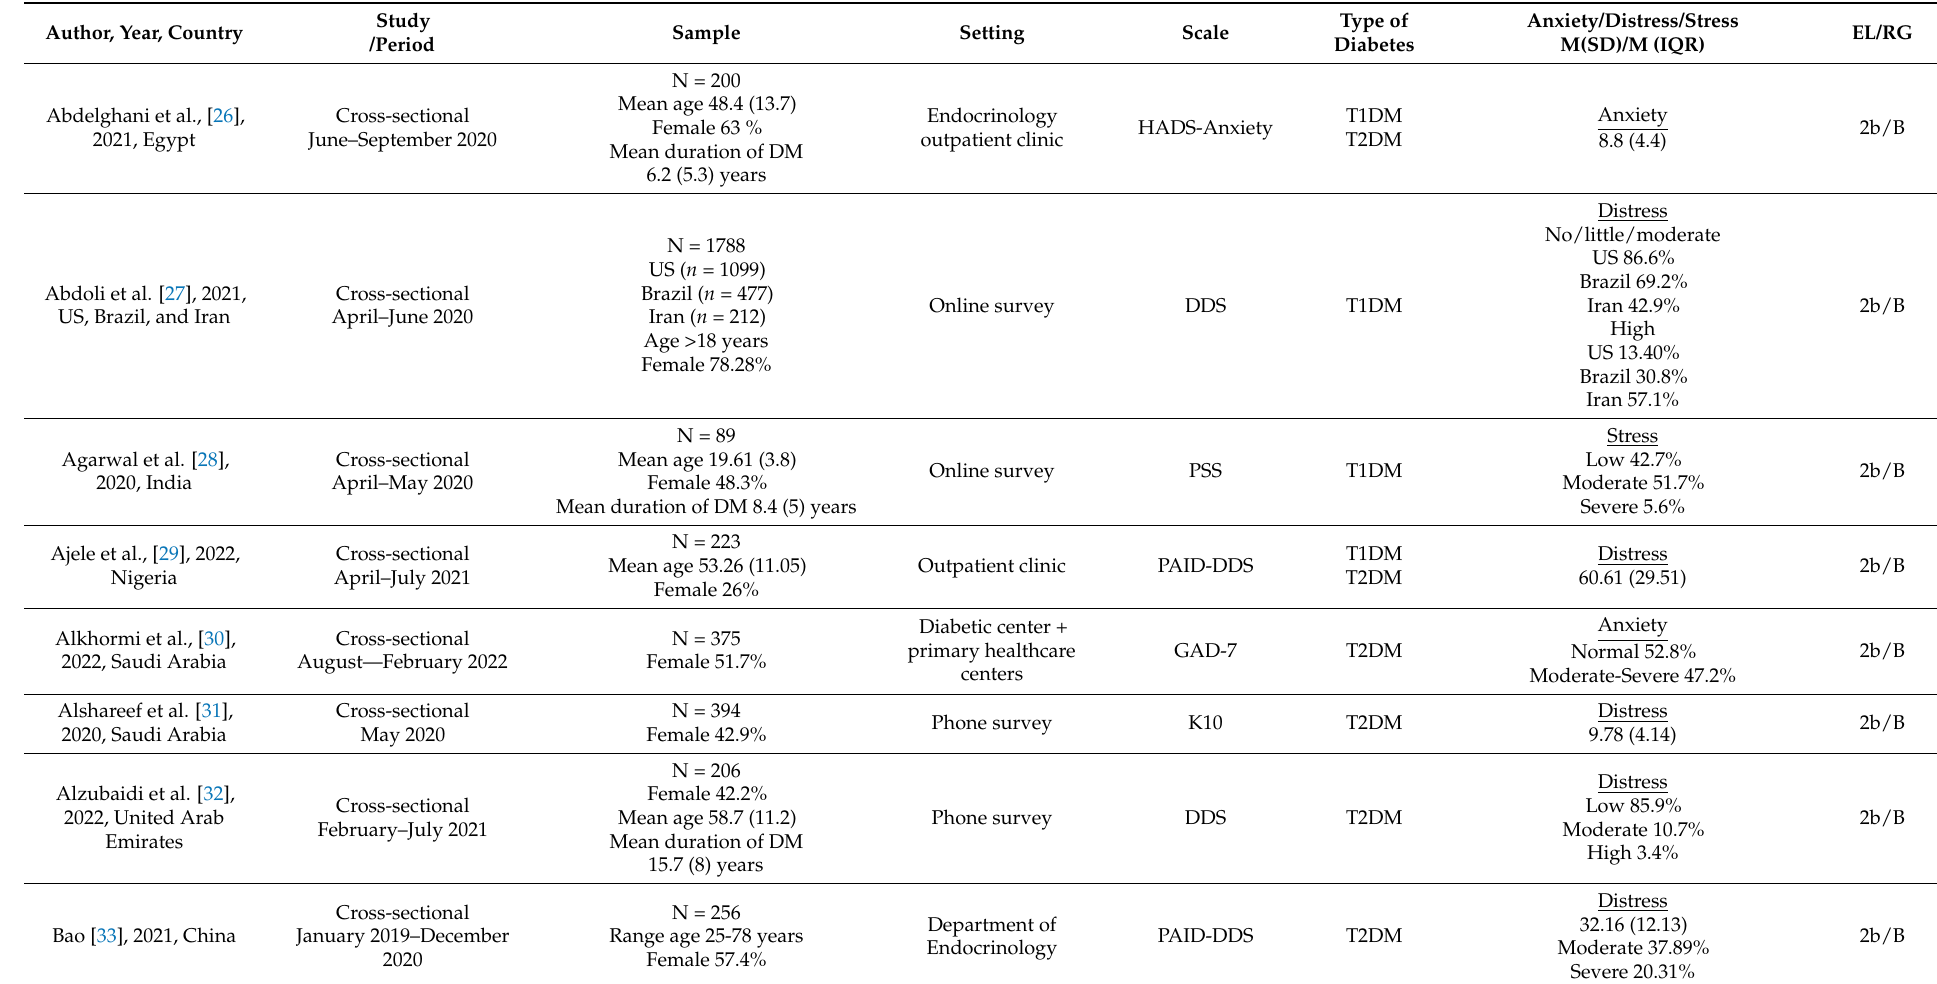
Table 1. Characteristics of the included studies ( n =